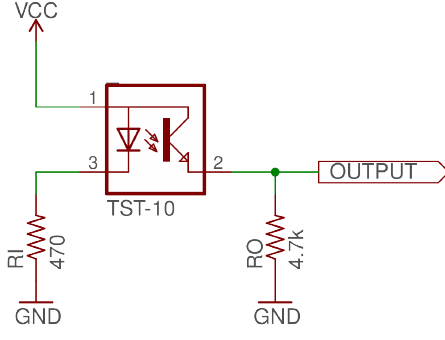
Figure 2. Amphenol (TST-10) appliance turbidity test circuit where VCC = 5 V. Other Amphenol models use the same circuit.